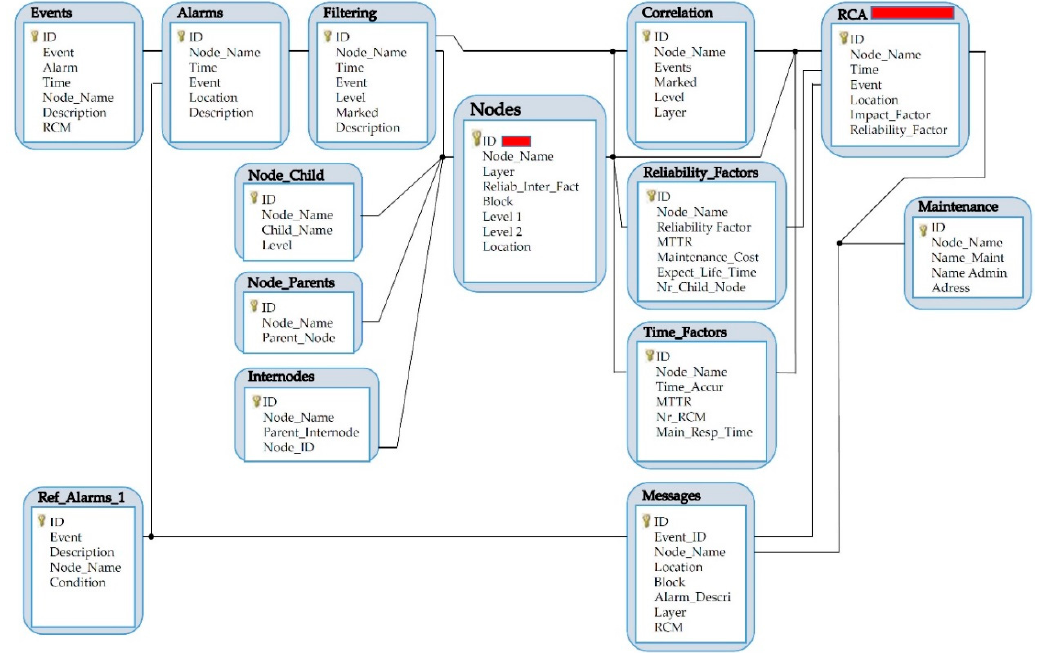
Figure 5. Tables with the entity relationship diagram (RCM: Root Cause Method, MTTR: Mean Time to Repair system).